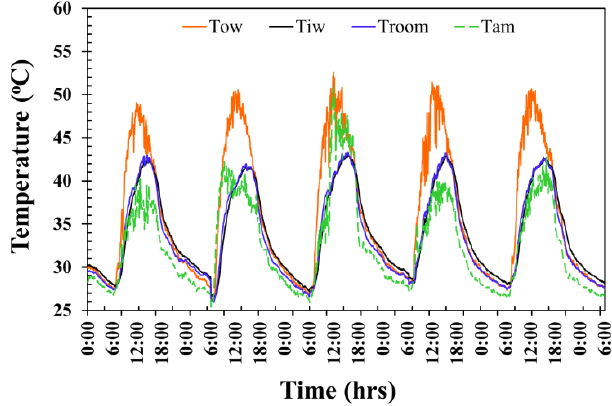
Figure 7. Temperature fluctuation of the ordinary AAC testing room wall.